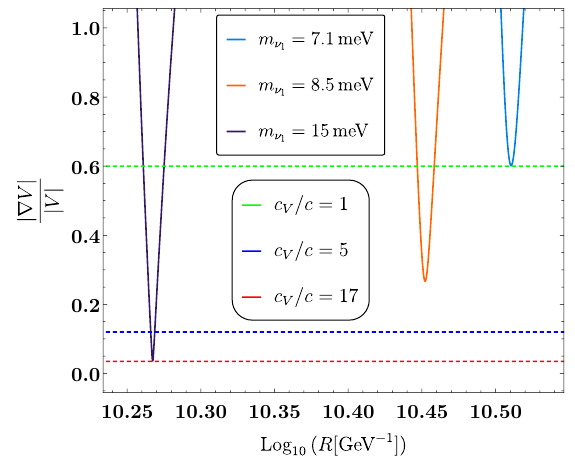
> 1 for a quintessence potential with c V = 0 . 6 for Dirac neutrinos in NH, Figure 7 . ( M 3 d p ) 1 / 2 |∇ V | | V | with c = 0 . 6 , 0 . 12 and 0 . 035 . For c = 0 . 6 we find the bound m we find the weaker bound m 15 ν l ≤